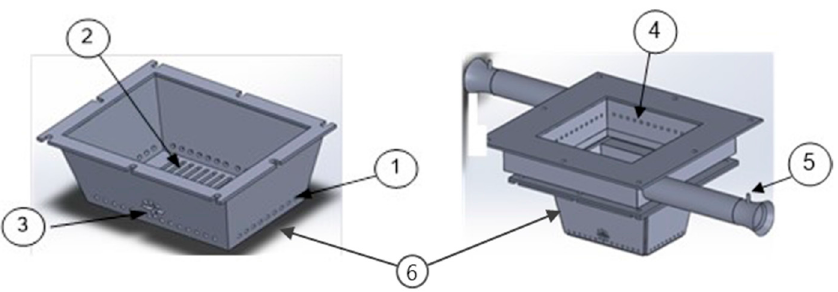
Figure 3. Grate Unit: 1–2. Primary air orifices; 3. Ignition hole; 4. Secondary air orifice; 5. Secondary air inlet 6. Bottom Grate.